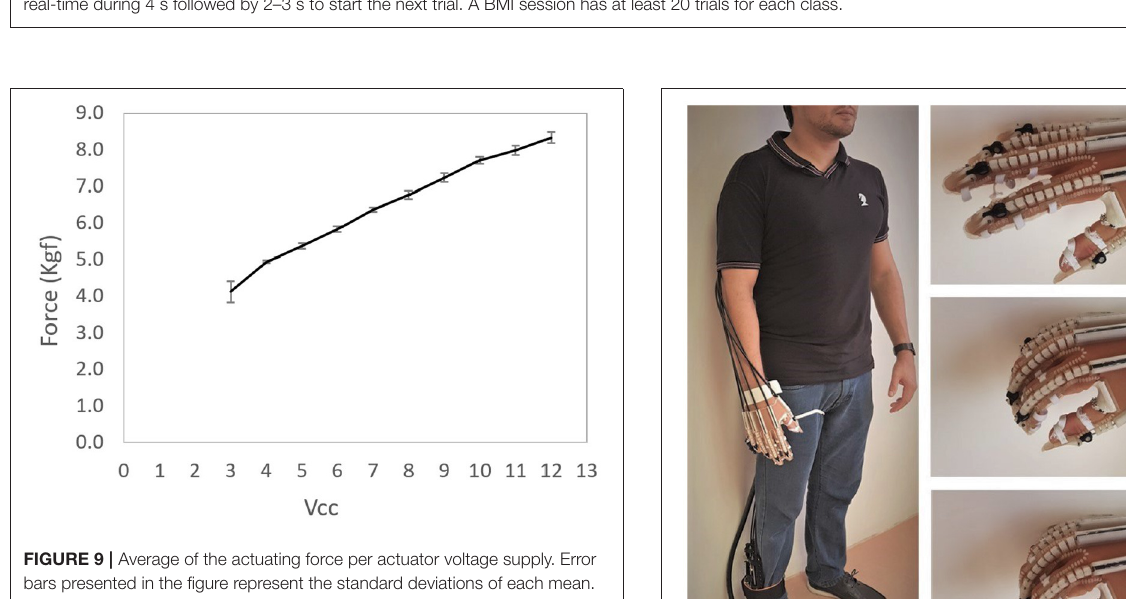
FIGURE 8 | A trial timeline representation of Graz-BCI paradigm on OpenVibe (OV). The participant is instructed to look at a black screen and wait for a green cross, which indicates the beginning of the trial. After 3 s, a red arrow cue appears randomly to the right or to the left. The left arrow indicates the task to relax (C1), and the right arrow indicates the task to perform right hand MI (C2), without any hand movement. After 1 s, a blue feedback bar appears to indicate MI performance in real-time during 4 s followed by 2–3 s to start the next trial. A BMI session has at least 20 trials for each class.